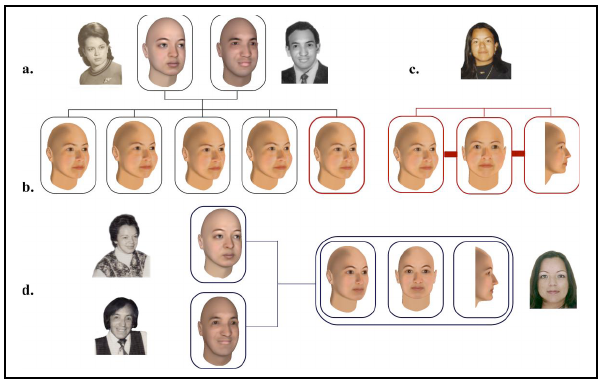
Figure 2. Missing person problem.